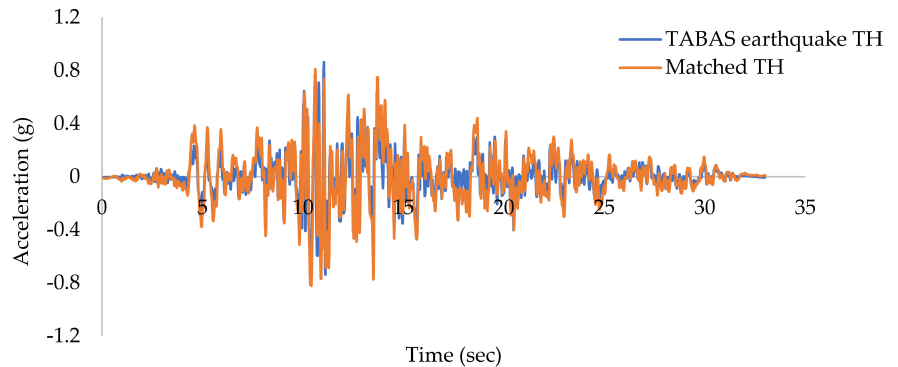
Figure 7. Tabas earthquake time history.